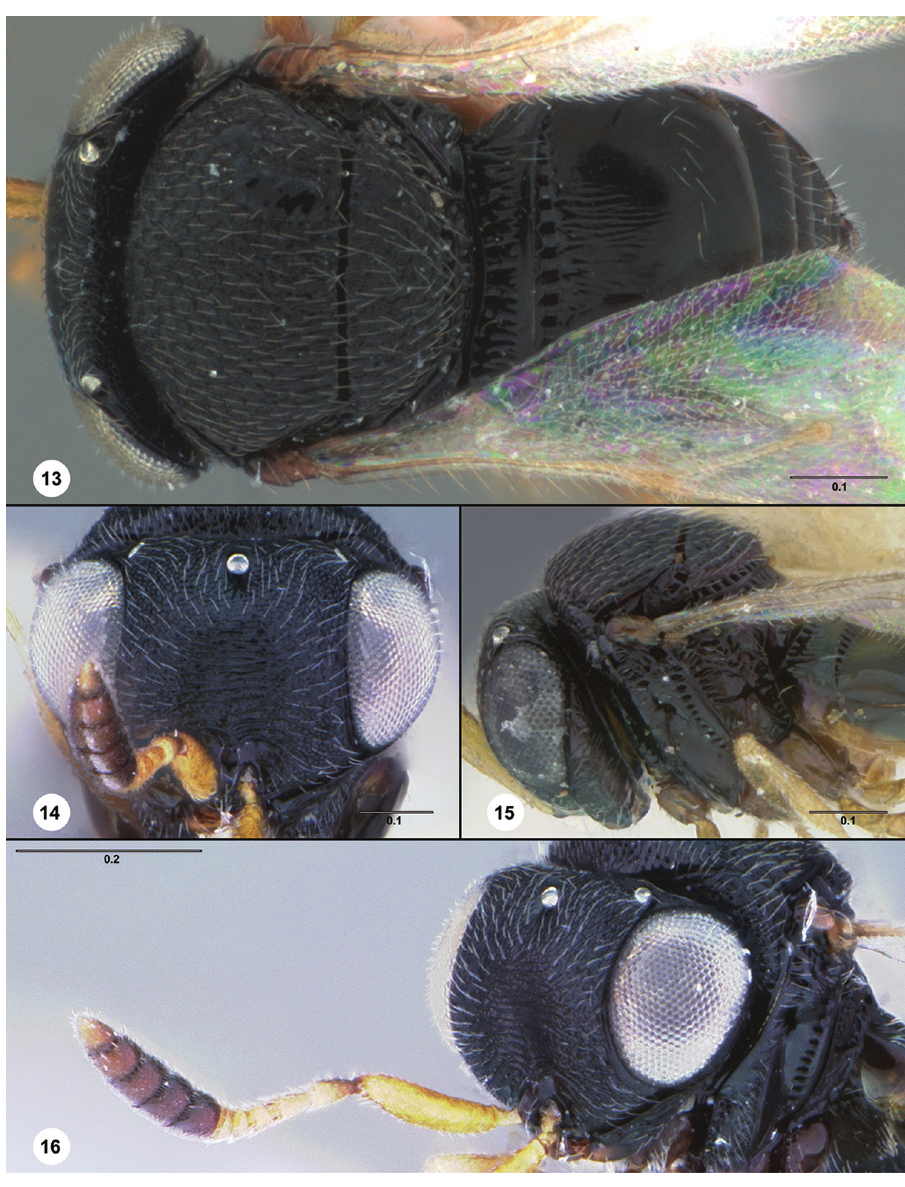
Figures 13–16. T. atys , female (USNMENT00896187) 13 female (USNMENT00896187) head, mes- osoma, metasoma, dorsal view 14 female (USNMENT00896187) head, anterior view 15 female holo- type (B.M. TYPE HYM. 9.245a), head and mesosoma, lateral view 16 female (USNMENT00896187) head and mesosoma, anterolateral view. Scale bars in